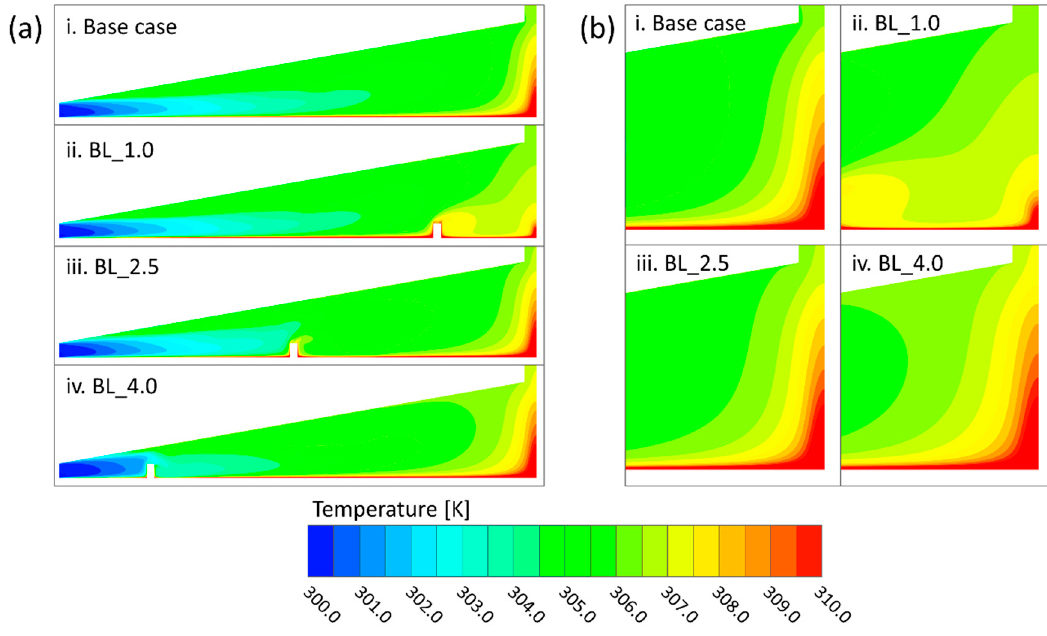
Figure 6. The temperature contours of the base case and the represented cases of each group (BL_1.0 of group 1, BL_2.5 of group 2, and BL_4.0 of group 3). ( a ) The contour of 20 compartments from 300 K to 310 K. ( b ) The zoomed inset images show contours near the central axis.